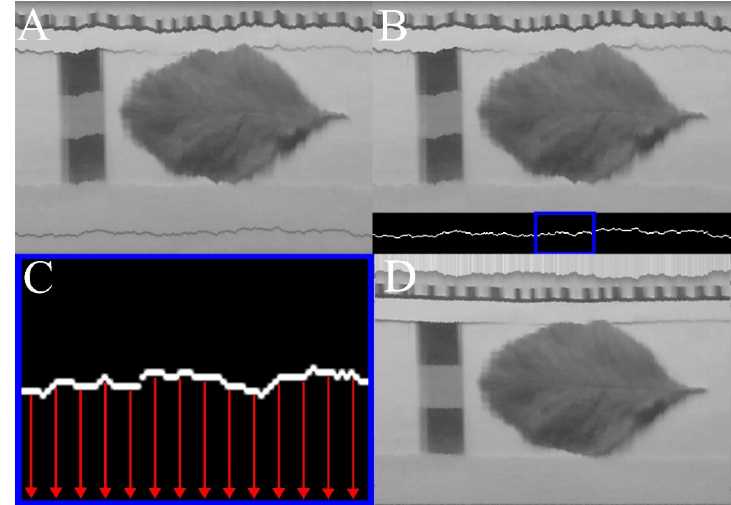
Figure 5. The stages of the vertical spatial correction. ( A ) is the raw output from the data cube. ( B ) shows the masked area of the vertical correction reference line overlayed onto the original image. The area highlighted in blue is shown, enlarged, in ( C ). The red arrows show the motion of the columns of pixels. ( D ) shows the corrected image. The top of the image has been left uncropped to make the effect of the column shifts clearer.